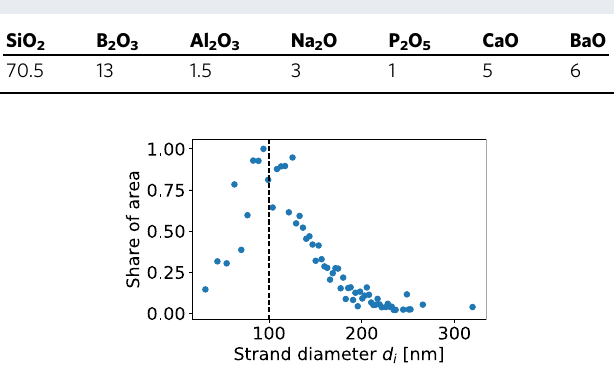
Fig. 5 Feature statistics of a phase-separated fi ber contrast image. Strand diameter statistics based on the cross-section contrast image from Fig. 2a. The distribution of equidistantly binned strand diameters d i ( x -axis) is plotted against the total area (on the y -axis) covered by all similarly large strands. The dashed line roughly indicates the average strand diameter d